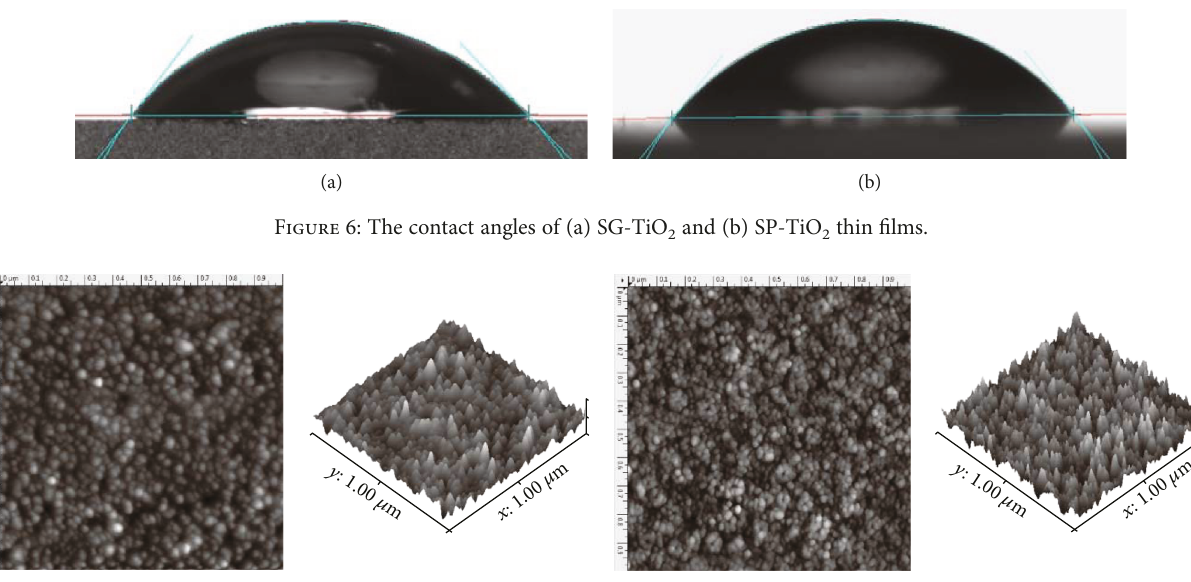
and (b) SP-TiO thin fi lms. 2 2 and SP-TiO 2 2